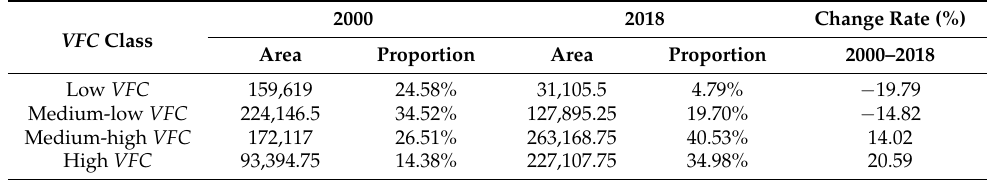
Table 2. Area statistics and changes in VFC classes in Loess Plateau from 2000 to 2018 (unit: km 2 ).